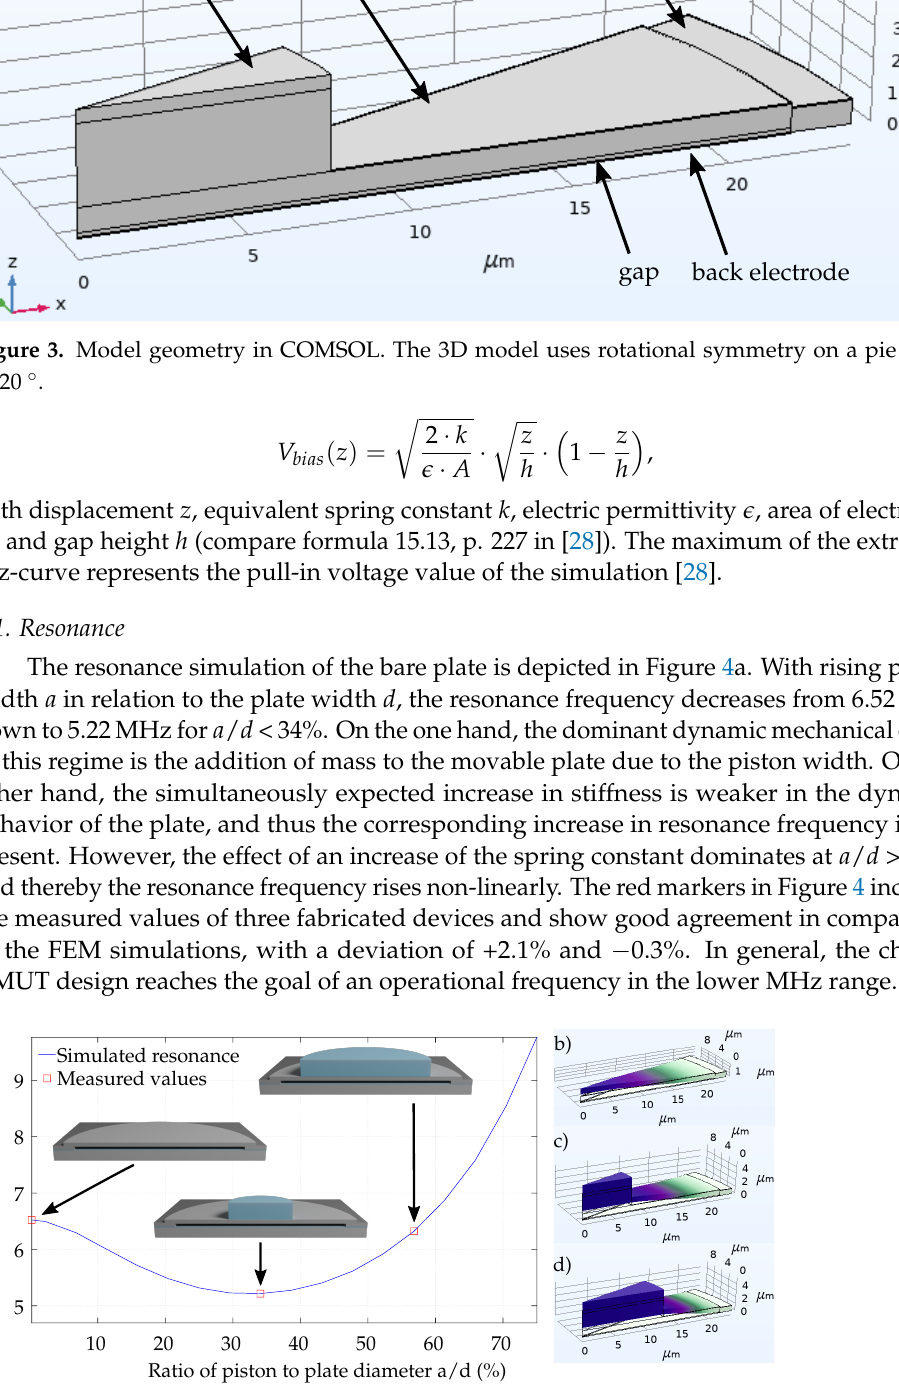
Figure 4. FEM simulation on resonance behavior. ( a ) Resonance frequency in dependence on piston width. The red squares indicate the realized sensors in the presented work. a = piston diameter; d = plate diameter; ( b – d ) Shapes of fundamental mode for plate without and with pistons. The dynamic displacement of the plate is dominated by regions where no piston is on the plate (ring around piston). The piston provides a non-flexural parallel plate